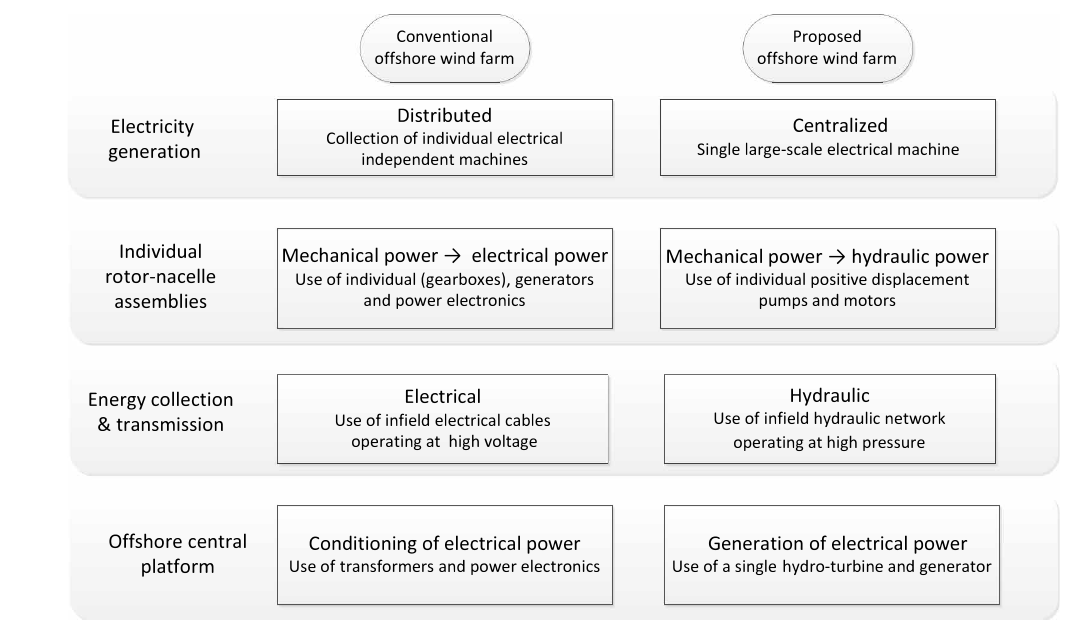
Figure 1. Conceptual comparison between a conventional and the proposed offshore wind